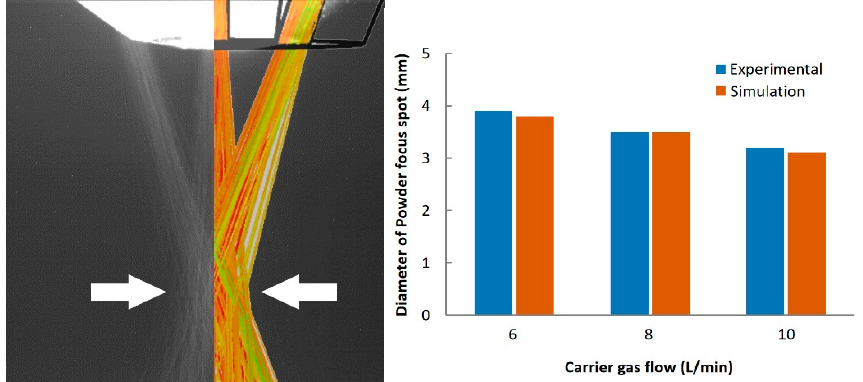
Figure 3. Comparison of simulation and experimental results of the powder spot diameter.